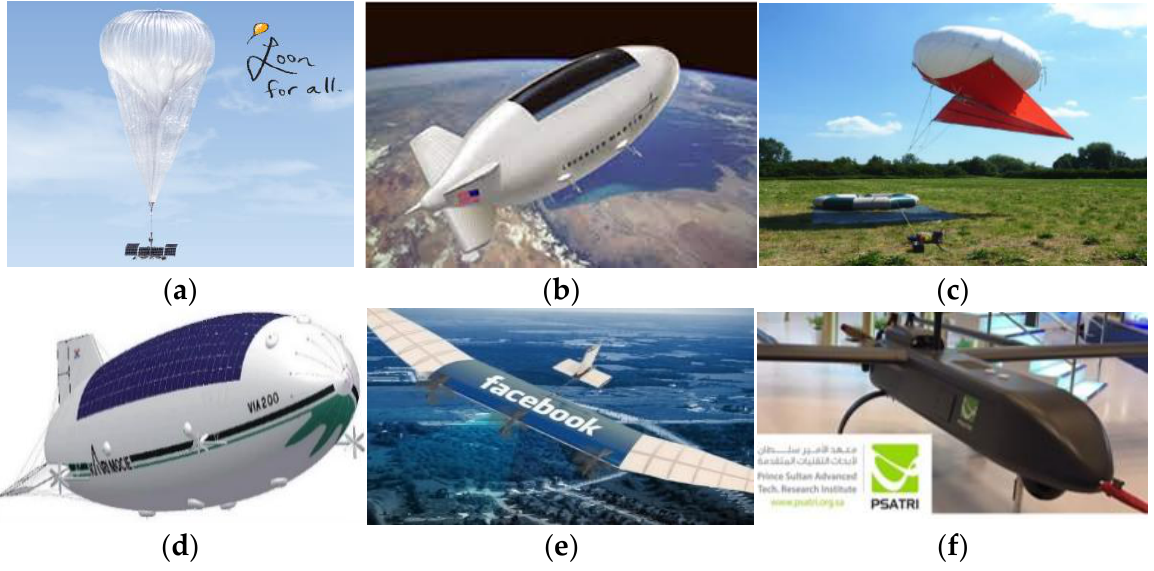
Figure 2. Aerial platform examples across the globe. ( a ) Google Loon—International, ( b ) HAA— USA, ( c ) ABSOLUTE Tethered Balloon—EU, ( d ) KARI—Korean, ( e ) Facebook fixed-wing Aircraft— International, ( f ) PSATRI Drone—KSA.